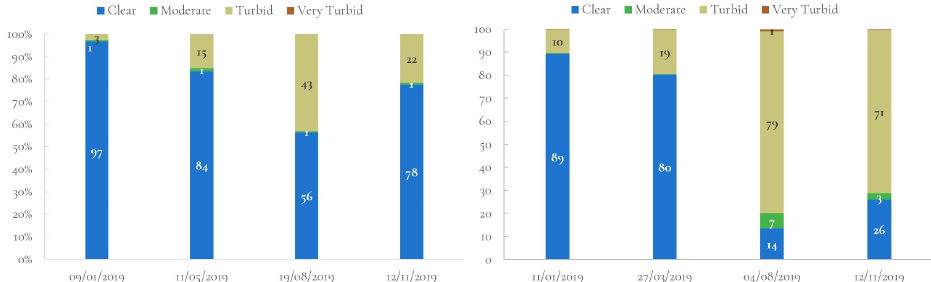
Figure 8. Temporal series of optical water types in Contreras ( left ) and Mediano ( right ) lakes.